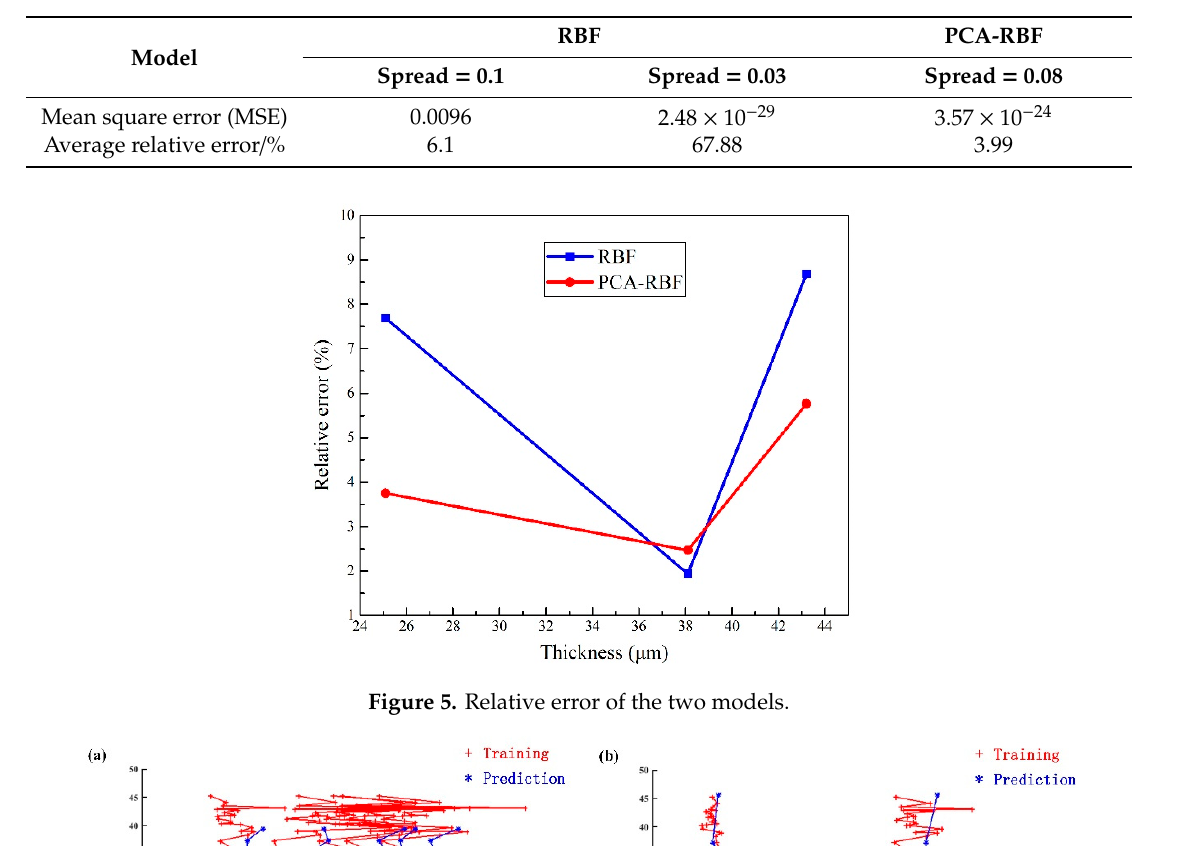
Table 8. The best mean square error and predicted results.